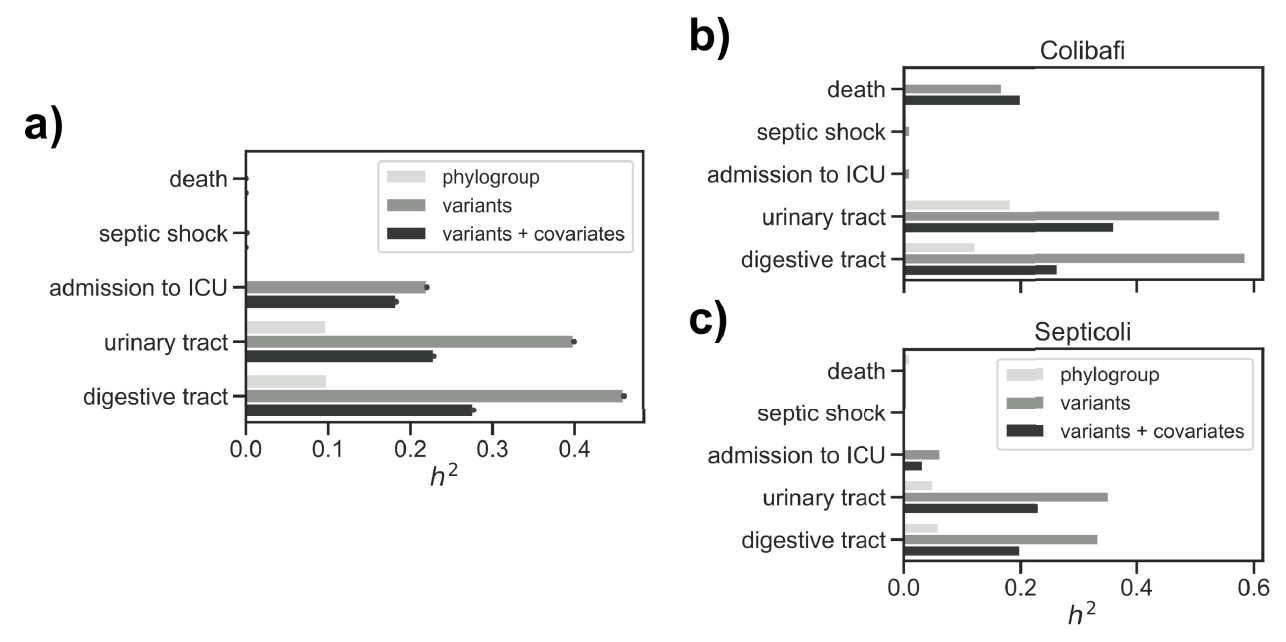
Fig 2. Narrow-sense heritability ( h 2 ) estimation for the target variables on the combined dataset. a) Heritability estimates in the two studies combined, using a covariance matrix generated from the isolates’ phylogroup (phylogroup), a kinship matrix generated from the unitigs presence/absence matrix (variants), and the same kinship matrix conditioned with the clinical variables (variants + covariates). b) Heritability estimates in the Colibafi and c) Septicoli cohorts